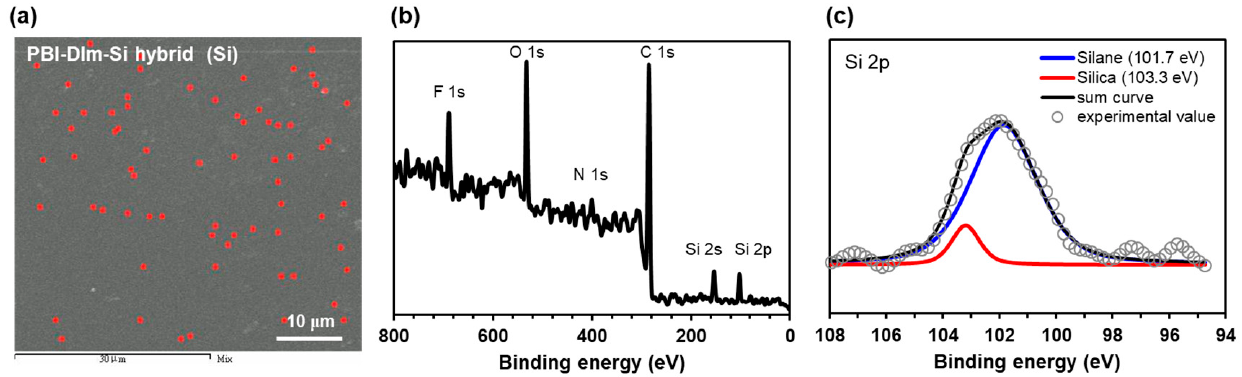
Figure 5. ( a ) EDX elemental mapping (red: silicon), ( b ) XPS full spectrum, and ( c ) high-resolution spectrum of Si 2p core-level peak for the PBI-DIm-Si hybrid membrane.